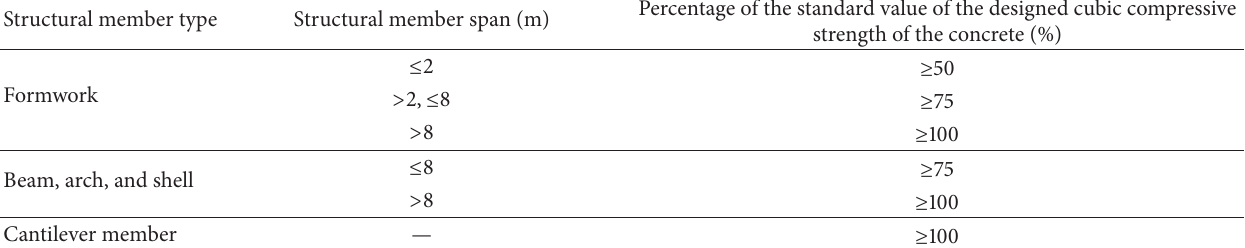
Table 1: Minimum requirements of concrete strength for the removal of underside formwork.